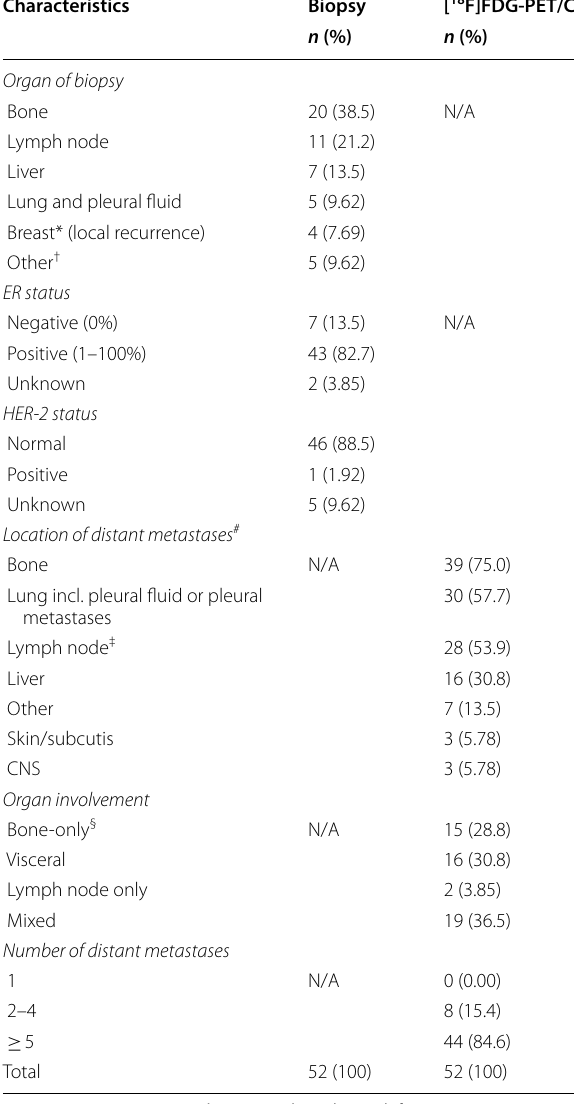
Table 2 The organ of distant biopsy and the corresponding immunohistochemical profile of metastatic lesions and the distribution of metastatic sites, organ involvement, and burden of the disease appear among 52 women diagnosed